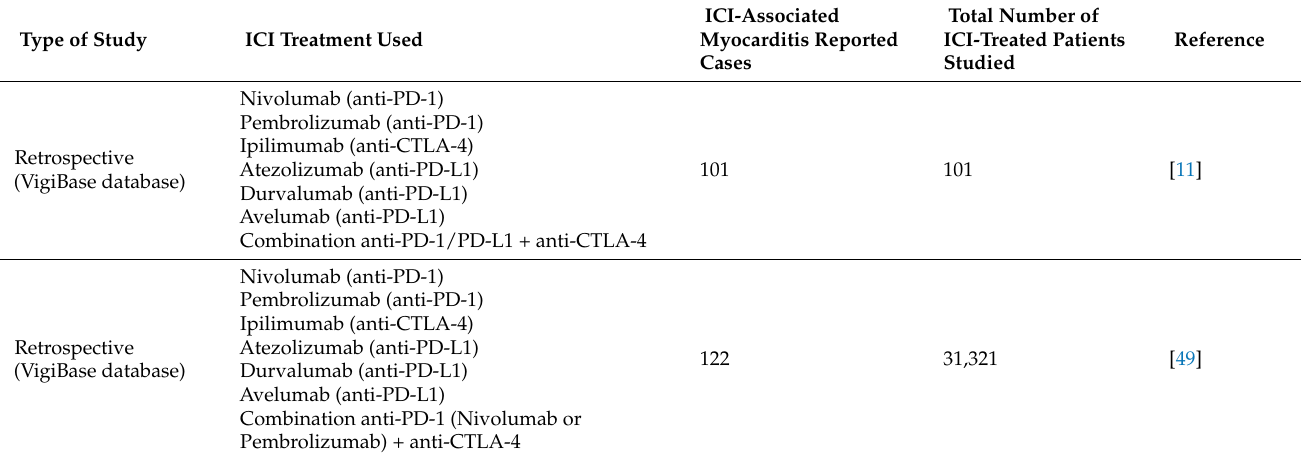
Table 2. Studies reporting cases of ICI-associated